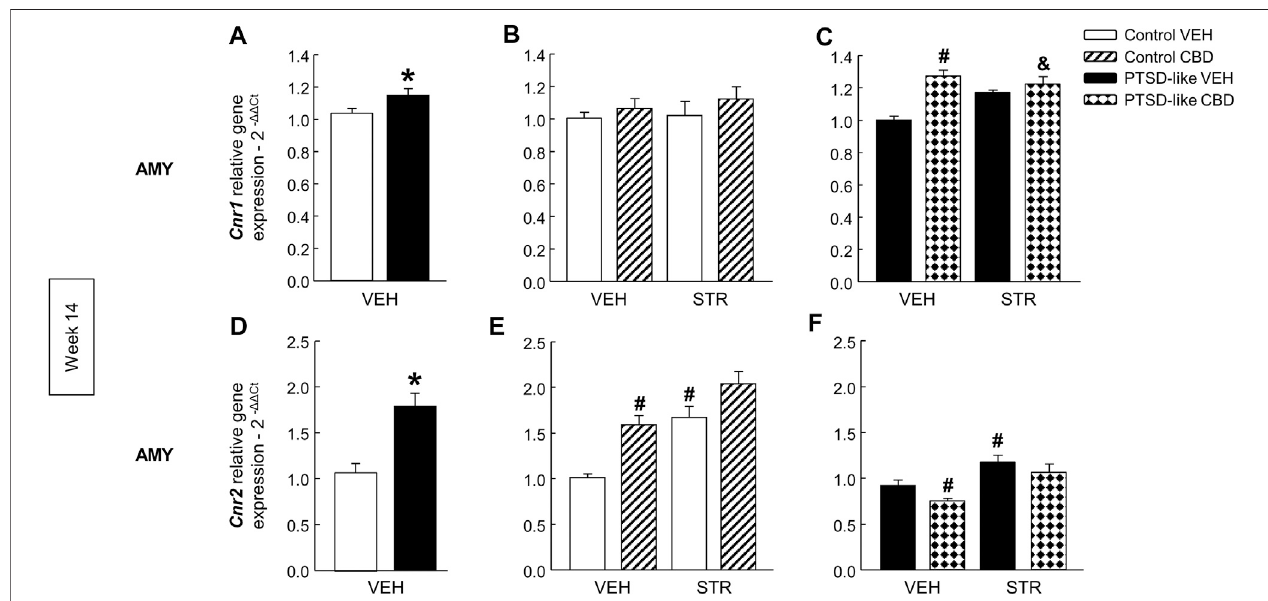
FIGURE 9 | Relative gene expression analyses of cannabinoid receptor 1 ( Cnr1 ) and 2 ( Cnr2 ) in the amygdala (AMY) by real time PCR at week 14. Comparative analysis between control and PTSD-like vehicle (VEH)-treated mice of the relative gene expression of Cnr1 (A) and Cnr2 (D) . Effects of CBD (20 mg/kg) and/or STR (10 mg/kg)administration,oritscorrespondingVEH,ontherelativegeneexpressionof Cnr1 (B,C) and Cnr2 (E,F) ofcontrolandPTSD-likemice.Columnsrepresentthe means and vertical lines ± SEM of 2 - ΔΔ Ct . *, Values from PTSD-like mice that are signi fi cantly different from control mice (Student ’ s t -test, Cnr1 : p < 0.05, Cnr2 : p < 0.001).#,ValuesfromCBD-orSTR-treatedmicethataresigni fi cantlydifferentfromVEH-treatedmice(Two-wayANOVA, p < 0.05).and,ValuesfromCBDplusSTR- treatedmicethataresigni fi cantlydifferentfromCBD-andSTR-treatedmice(Two-wayANOVA, p < 0.05).MiceexposedtothePTSD-likemodel:N(VEH) (cid:2) 10,N(CBD) (cid:2) 9, N(STR) (cid:2) 9, N(CBD plus STR) (cid:2) 10; control mice: N(VEH) (cid:2) 10, N(CBD) (cid:2) 9, N(STR) (cid:2) 9, N(CBD plus STR) (cid:2) 10.